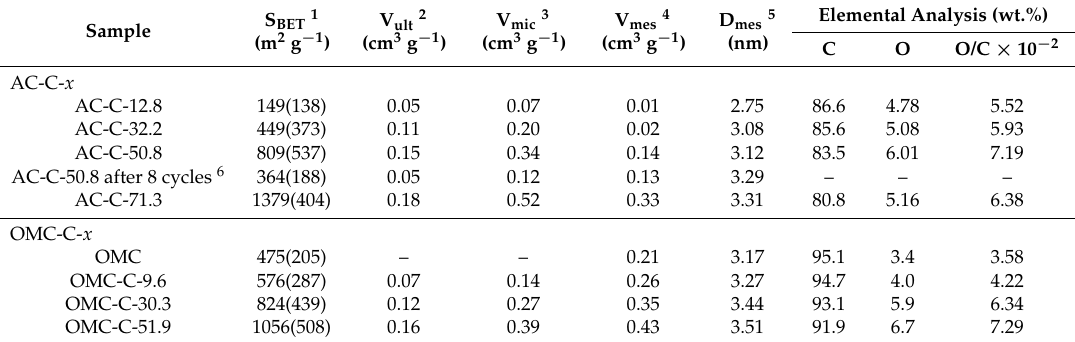
calculated by the Horvath–Kawazoe (HK) method. 4 V mes , 5 D mes : Mesopore (2–50 nm) volume and median mesopore diameter, calculated by applying the BJH method. 6 AC-C-50.8 after 8 cycles: AC-C-50.8 sample after eight cycles of desulfurization and water-washing